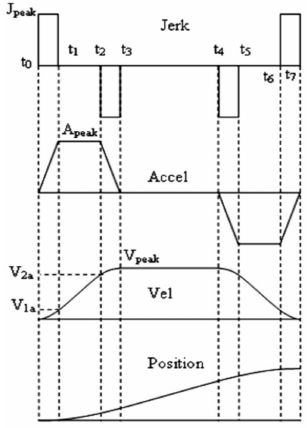
Figure 19. Description of the polynomial S-curve for the motion